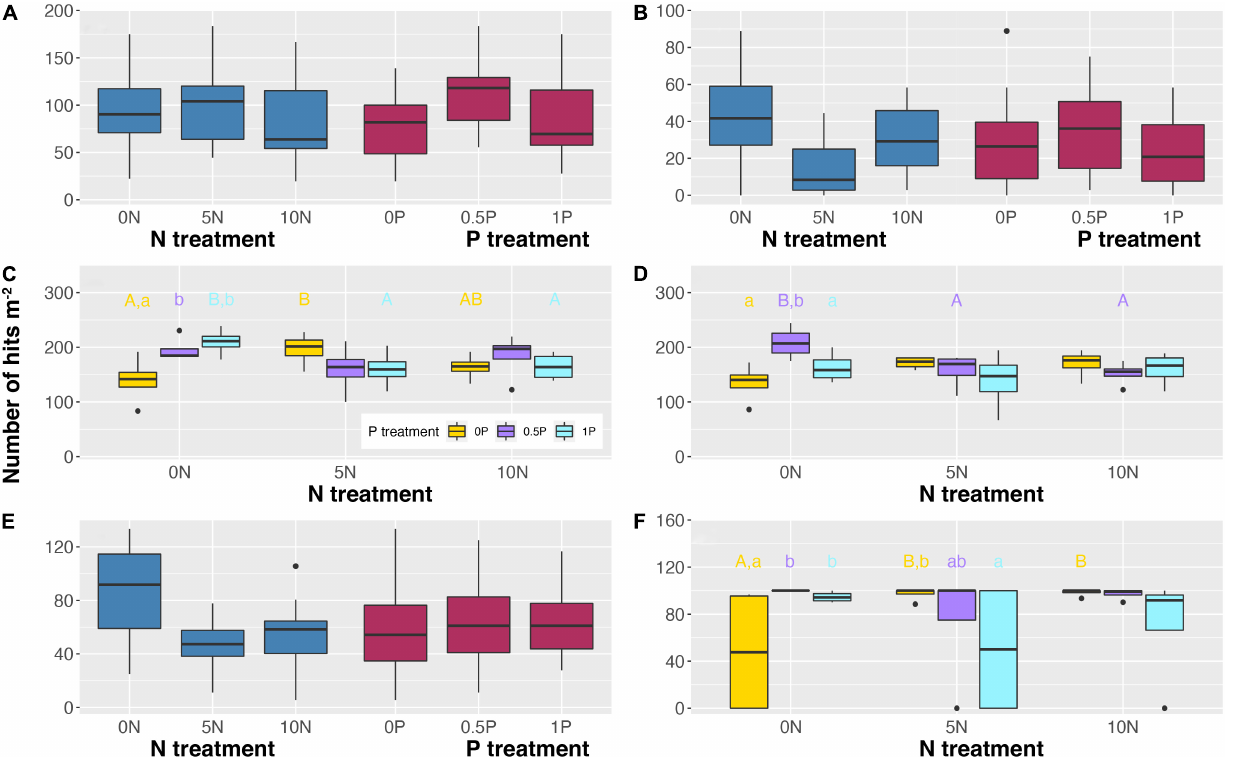
Frontiers in Microbiology |